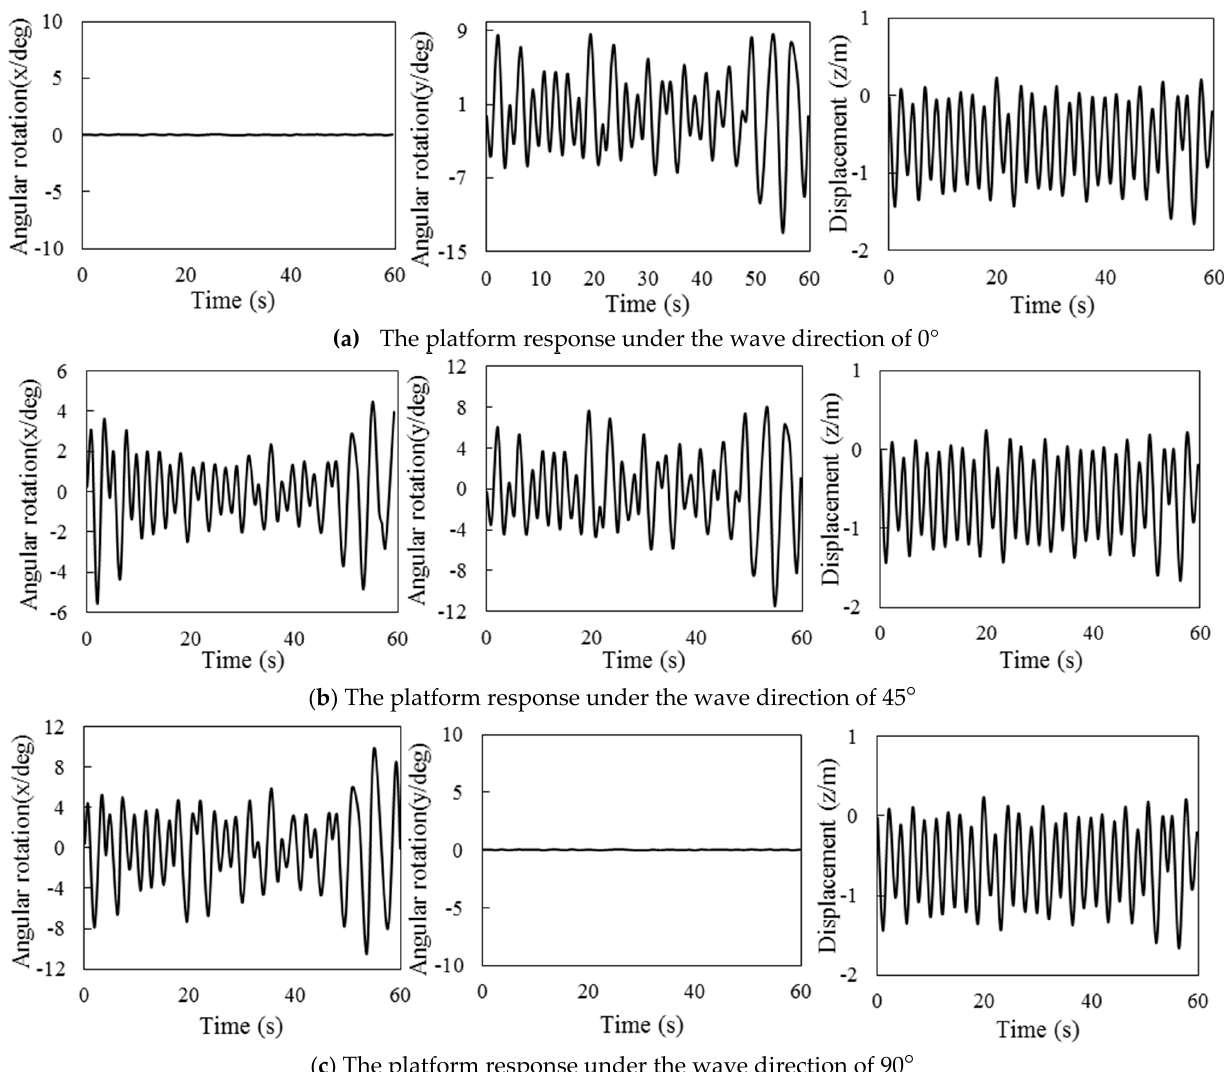
Figure 8. The platform response under wind − sea scale 3 with different wave directions.